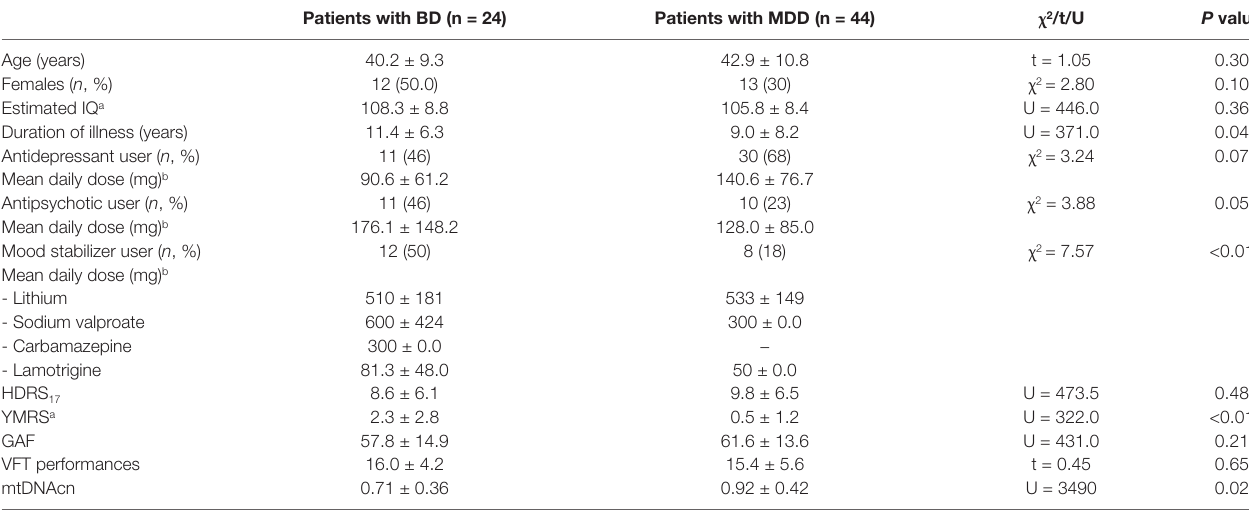
TABLE 1 | Demographics of patients with bipolar disorder and patients with major depressive disorder. Patients with BD (n = 24) Patients with MDD (n =